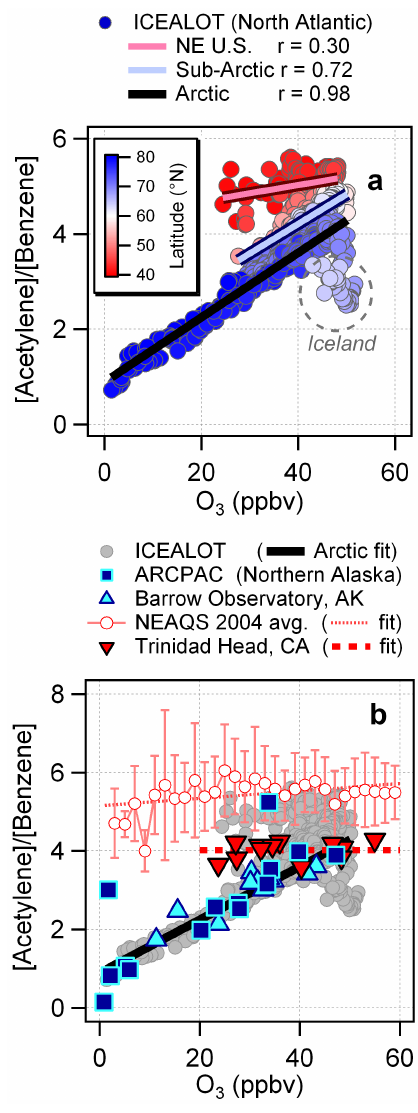
Fig. 3. (a) Scatter plots of [Acetylene]/[Benzene] versus O 3 for the ICEALOT campaign. The data points have been colored by lati- tude. Linear fits and corresponding correlation coefficients for the NE US, sub-Arctic, and Arctic data subsets of the ICEALOT cam- paign are included. (b) Scatter plots of [Acetylene]/[Benzene] ver- sus O 3 for the flask samples from ARCPAC, Barrow, and Trinidad Head as well as the mean [Acetylene]/[Benzene] ± 1 σ from NEAQS 2004. Linear fits to Trinidad Head and NEAQS 2004 datasets are shown. The ICEALOT data and fit to the Arctic data subset, which appear in panel (a), have been included in panel (b) for